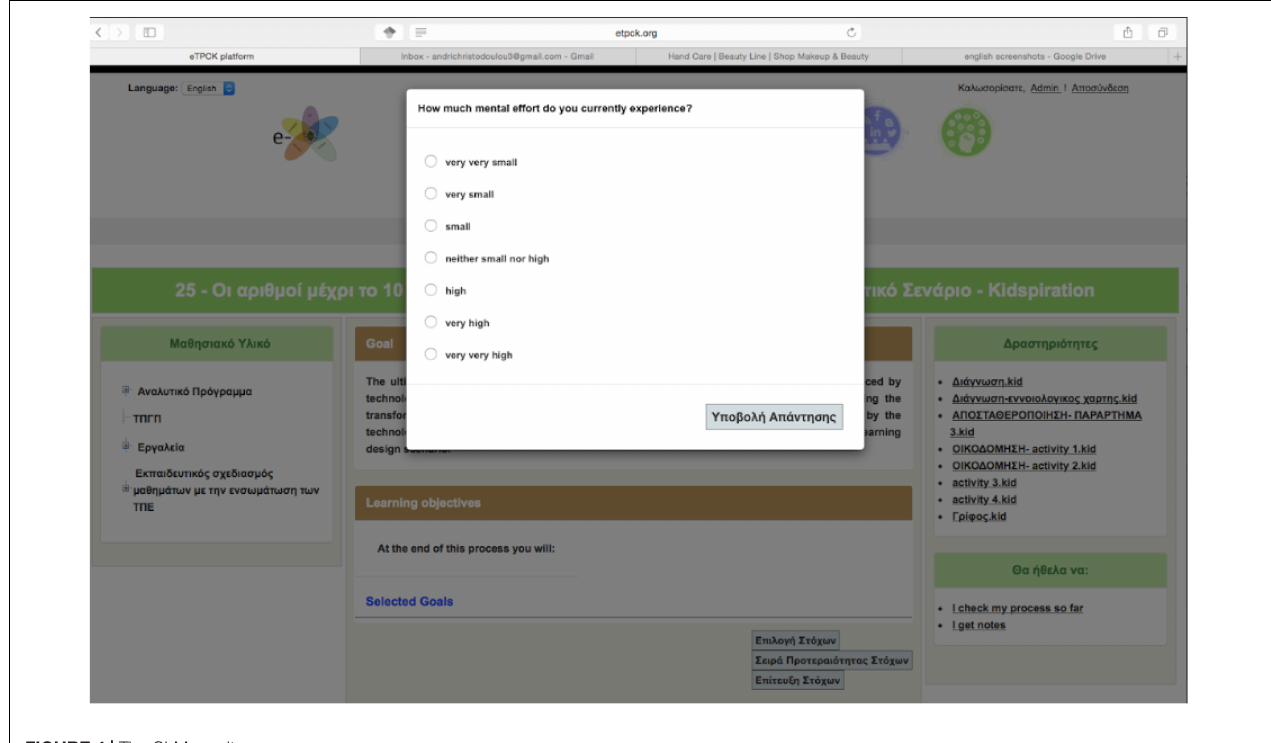
FIGURE 4 | The CLM monitor.